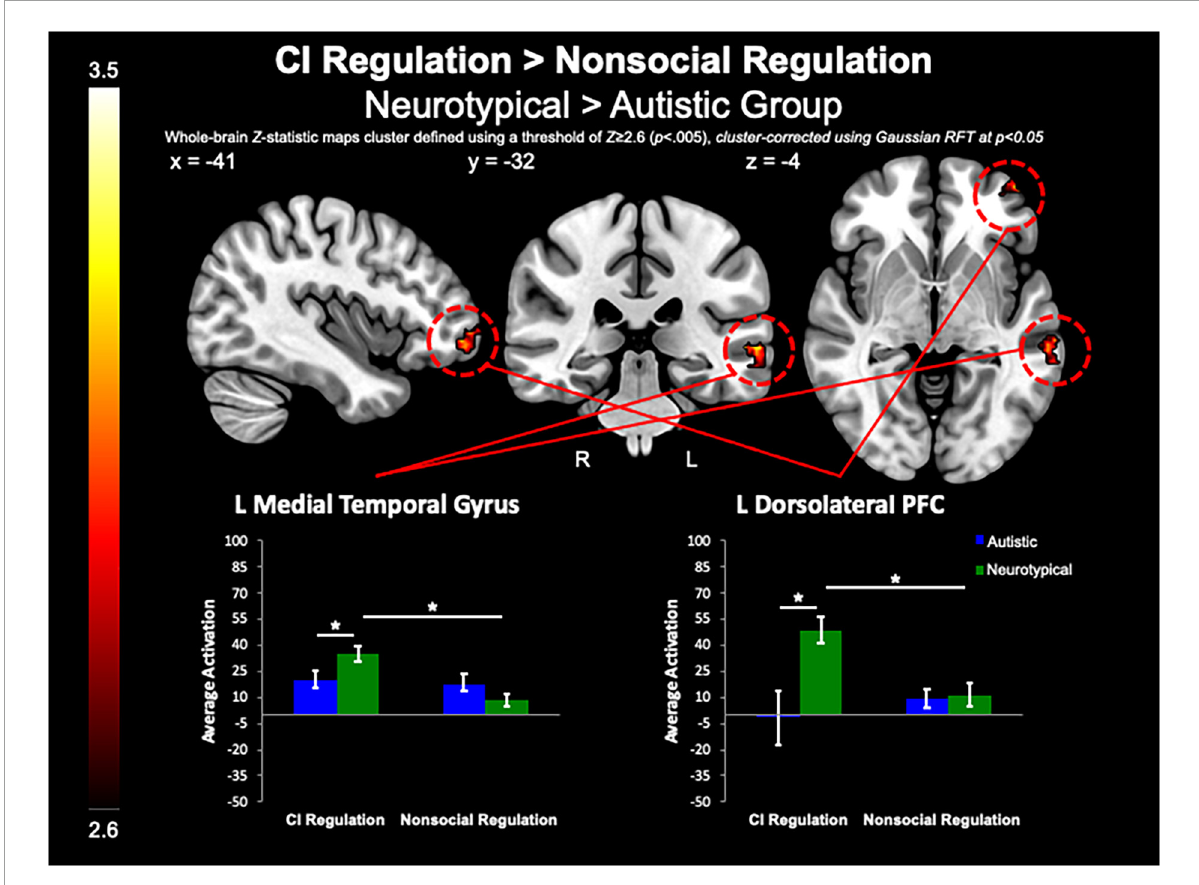
FIGURE6 CI regulation > nonsocial regulation. Compared to the autistic group, the control group demonstrated increased activation of the L MTG, and dlPFC when regulating affect toward CI vs. regulating affect toward nonsocial object